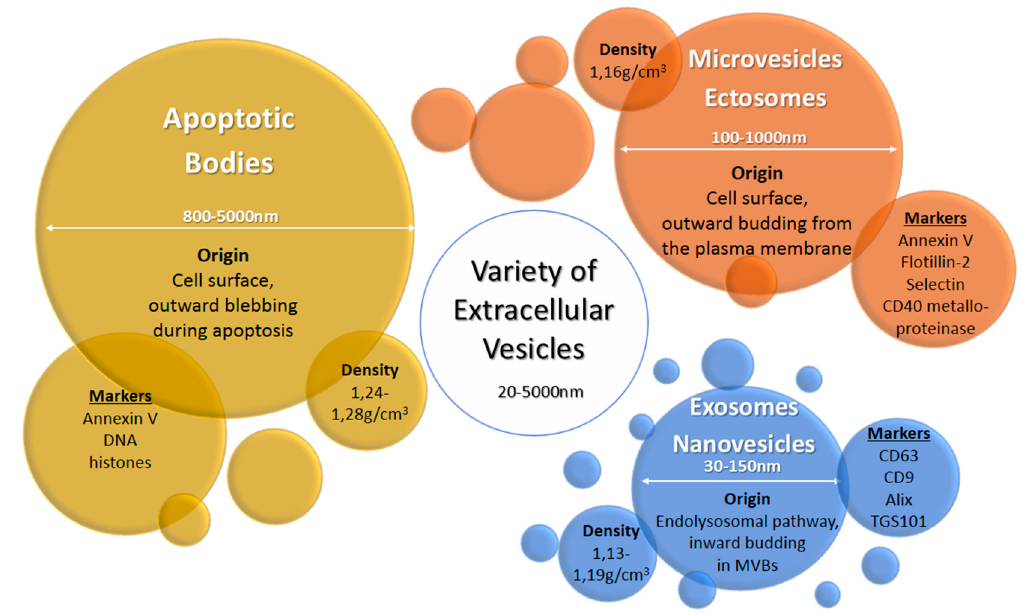
Figure 1. Origin, size, density, and typical markers of major extracellular vesicle subclasses